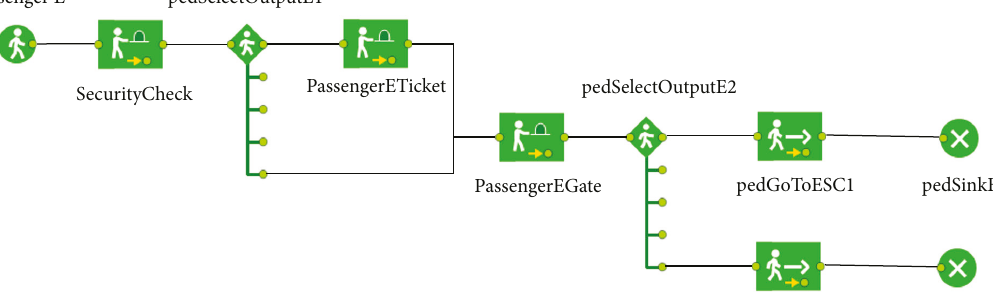
Figure 4: Route design of passengers entering from Entrance